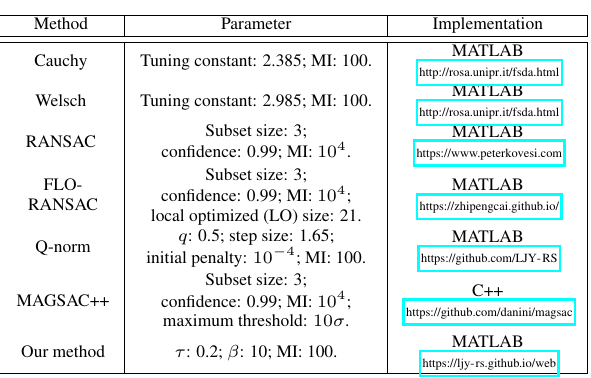
Table 1. Detailed settings of the compared methods (MI repres- ents maximum number of